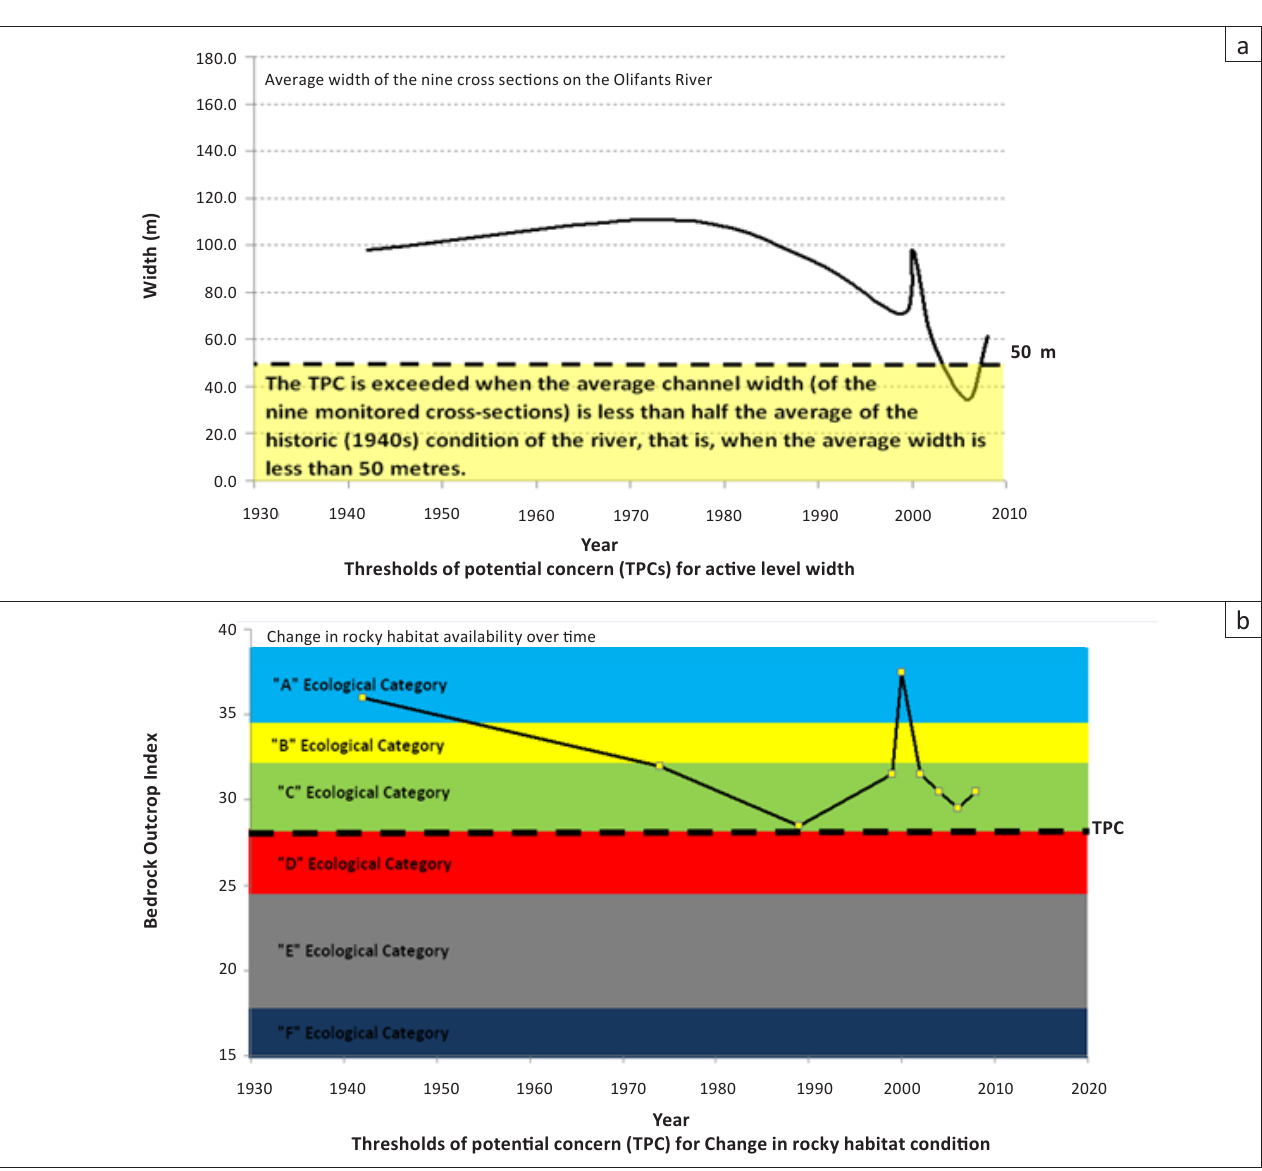
Source : Rountree, M., McLoughlin, C.A., Mackenzie, J., Deacon, A. & Sithole, H., 2008, ‘Kruger National Park TPC data collection, testing and implementation’, unpublished Water Research Commission report. Broken black line, threshold level associated with river habitat condition. Exapmle taken from Olifants River. FIGURE 4: Development of the new geomorphology thresholds of potential